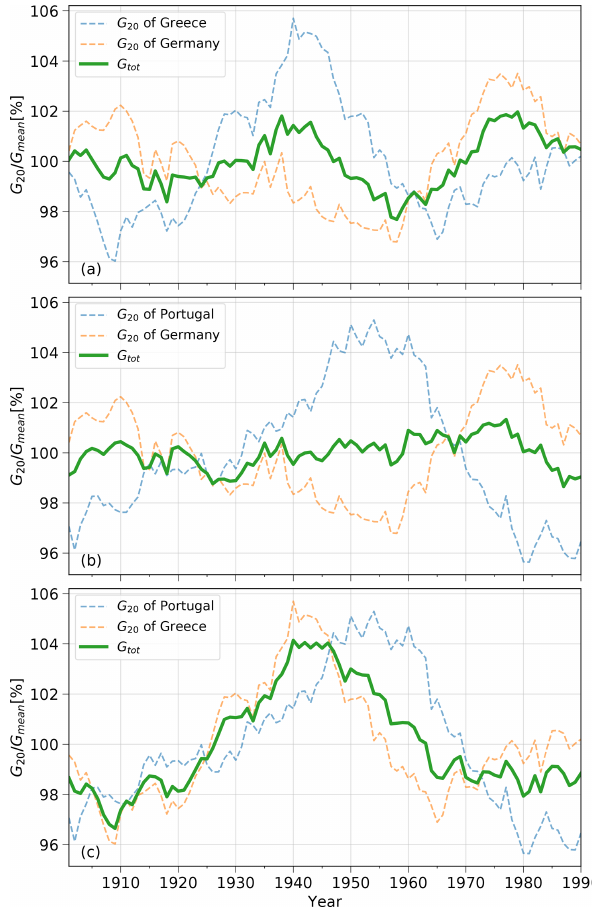
Figure 5. Normalized 20year running mean in relation to the NAO anomaly. Blue denotes the normalized 20year running mean of wind power generation potential in DJF of the ensemble mean (grey denotes same for each ensemble member) at three different locations: (a) Portuguese Atlantic Coast, (b) Greek Mediterranean, (c) German North Sea. Yellow lines show the 20-year running mean of the NAO anomaly.